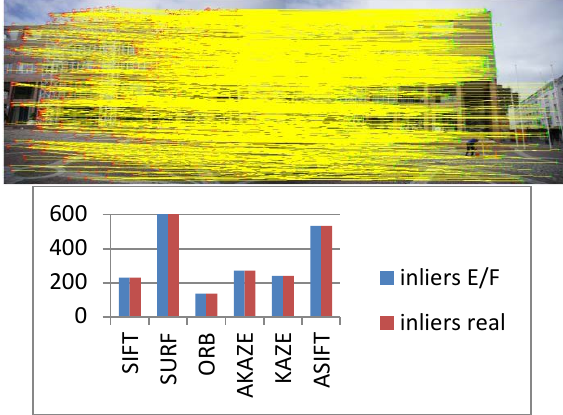
Figure 4: pair-1 results. Upper: SURF matches, lower: for each number of matches after E-/and F-based filtering (blue) and real inliers (red) 3 Pair 2 – within terr-2: 2392-2342 (perspective/rotation) This pair is a bit more challenging than the first one in two respects: the viewpoint and image rotation changes in a way to include the 2nd facade. The rotation is quite small, though. In addition the orientation of one camera changes from landscape to portrait mode. This is done in close range projects for two reasons. Sometimes the opening angle of the camera in landscape mode does not allow for acquiring the façade in the entire vertical direction. Additionally, by rotating the camera by 90° the self-calibration of interior parameters is supported, in particular the estimation of the principal point.